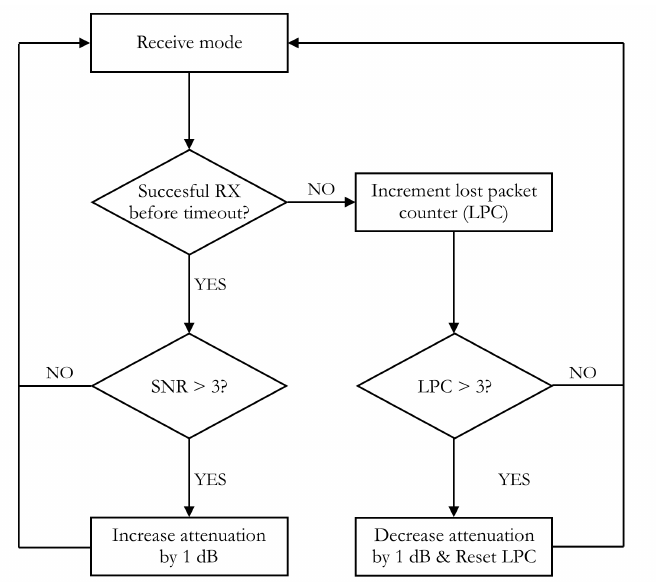
Figure 4. Flowchart of the attenuation adjustment